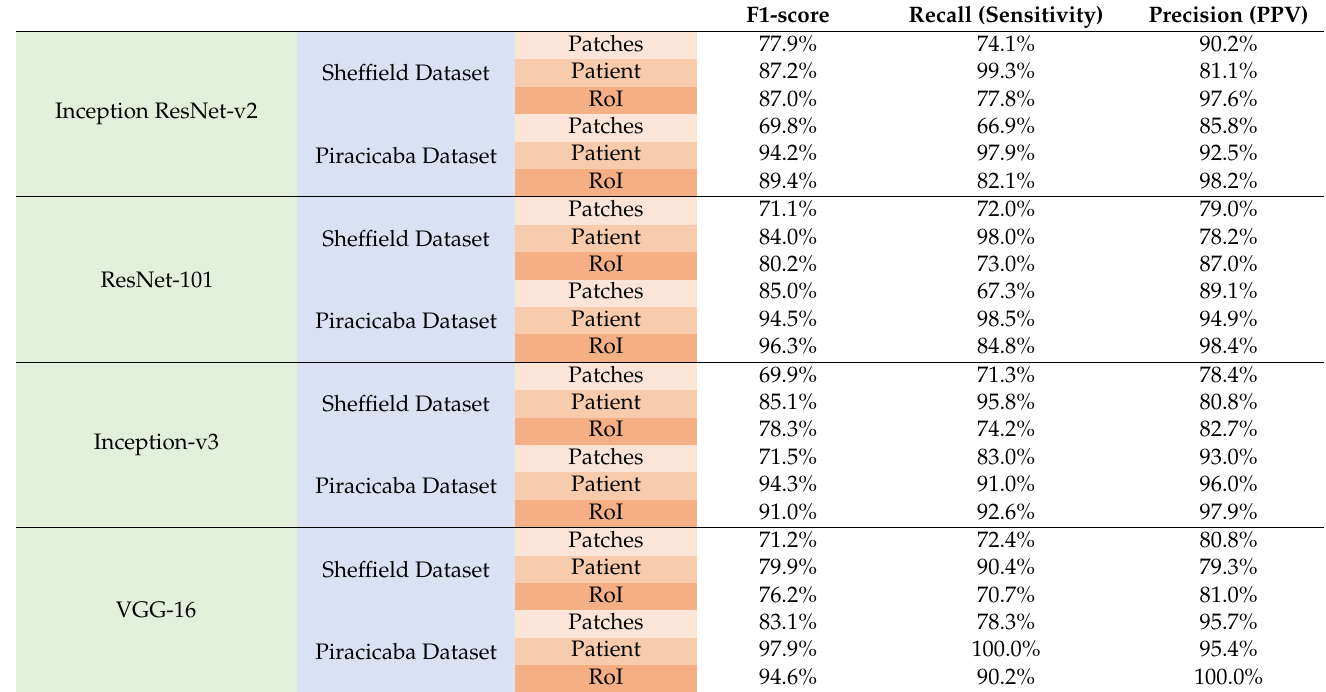
Table 5. Leave-one-patient-out cross-validation F1-score, recall, and precision for Sheffield and Piracicaba datasets.